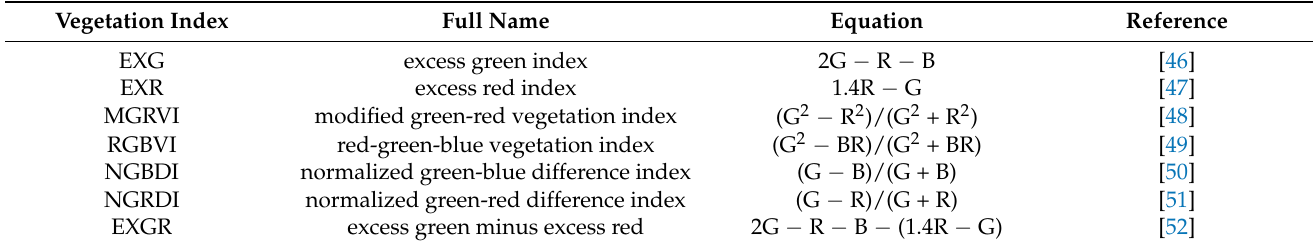
Table 2. Seven vegetation index features and corresponding equations (R, G, and B represent the mean value of red, green, and blue bands).